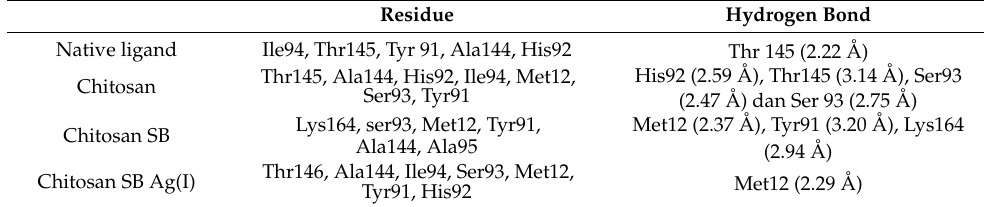
Table 6. The interaction of Staphylococcus aureus amino acids with various